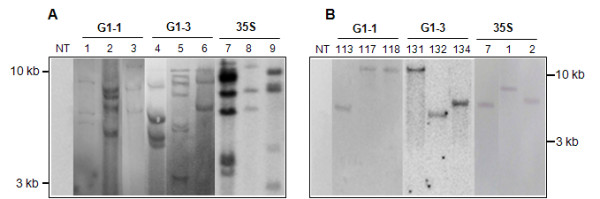
DNA blots of genomic DNA isolated from (A)Gladiolusand (B)Arabidopsisplants containing theuidAgene under control of either the CaMV 35 S (35 S), G1-1, or G1-3 promoter. Genomic is digested with Hind III and hybridized with a 511 bp uidA specific probe. Numbers indicate the transgenic plant lines or non-transformed (NT) plant. Two size markers, 3 and 10 kb, are shown.